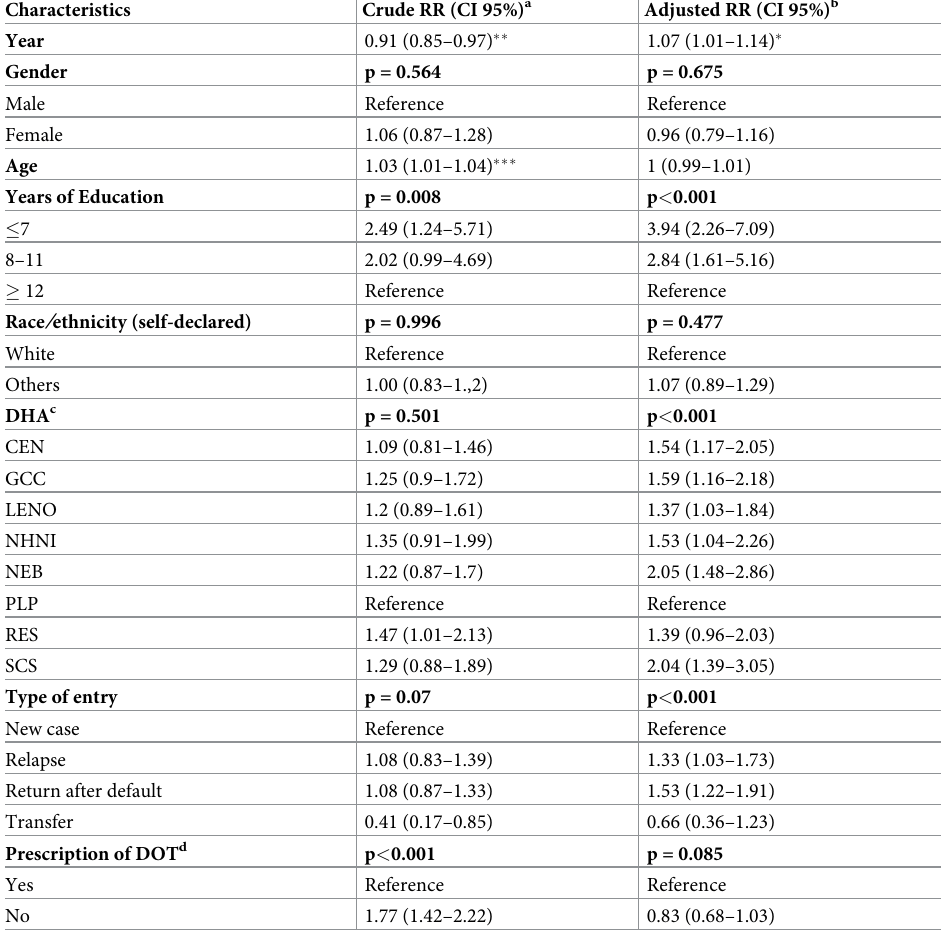
Table 3. Risk factors for mortality in cases of TB/HIV co-infection in Porto Alegre, from 2009 to 2013.